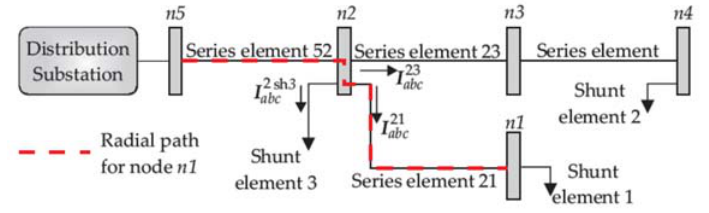
Figure 8. Representative radial distribution system.